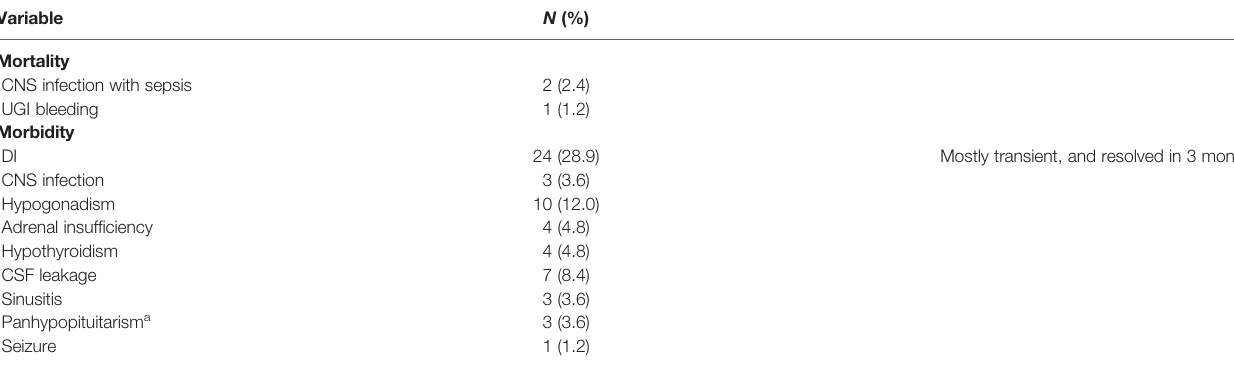
TABLE 2 | Mortality and morbidity through all pateints after fi rst